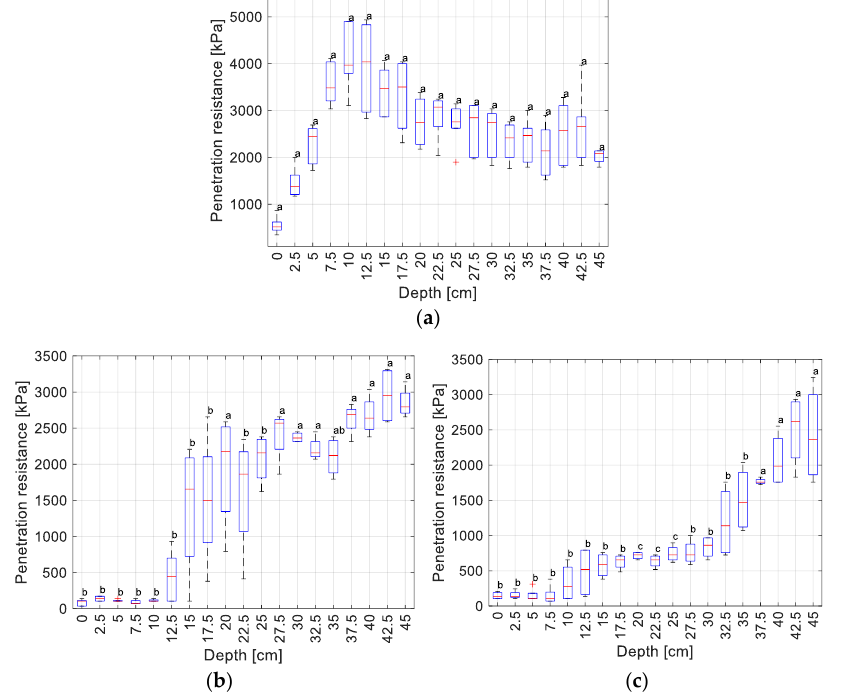
Figure 7. Cone penetration test results before the tillage ( a ), after the tillage in the parcel worked with conventional tillage ( b ), and after the tillage in the parcel worked with the Rotoripper ( c ). Each boxplot shows the median values of the repetitions with a red line, the 25th–75th percentile with a blue box, the maximum/minimum with whiskers, and the outliers with red crosses. Values with the same letter on the same depth do not differ statistically ( p > 0.05) by the ANOVA test.